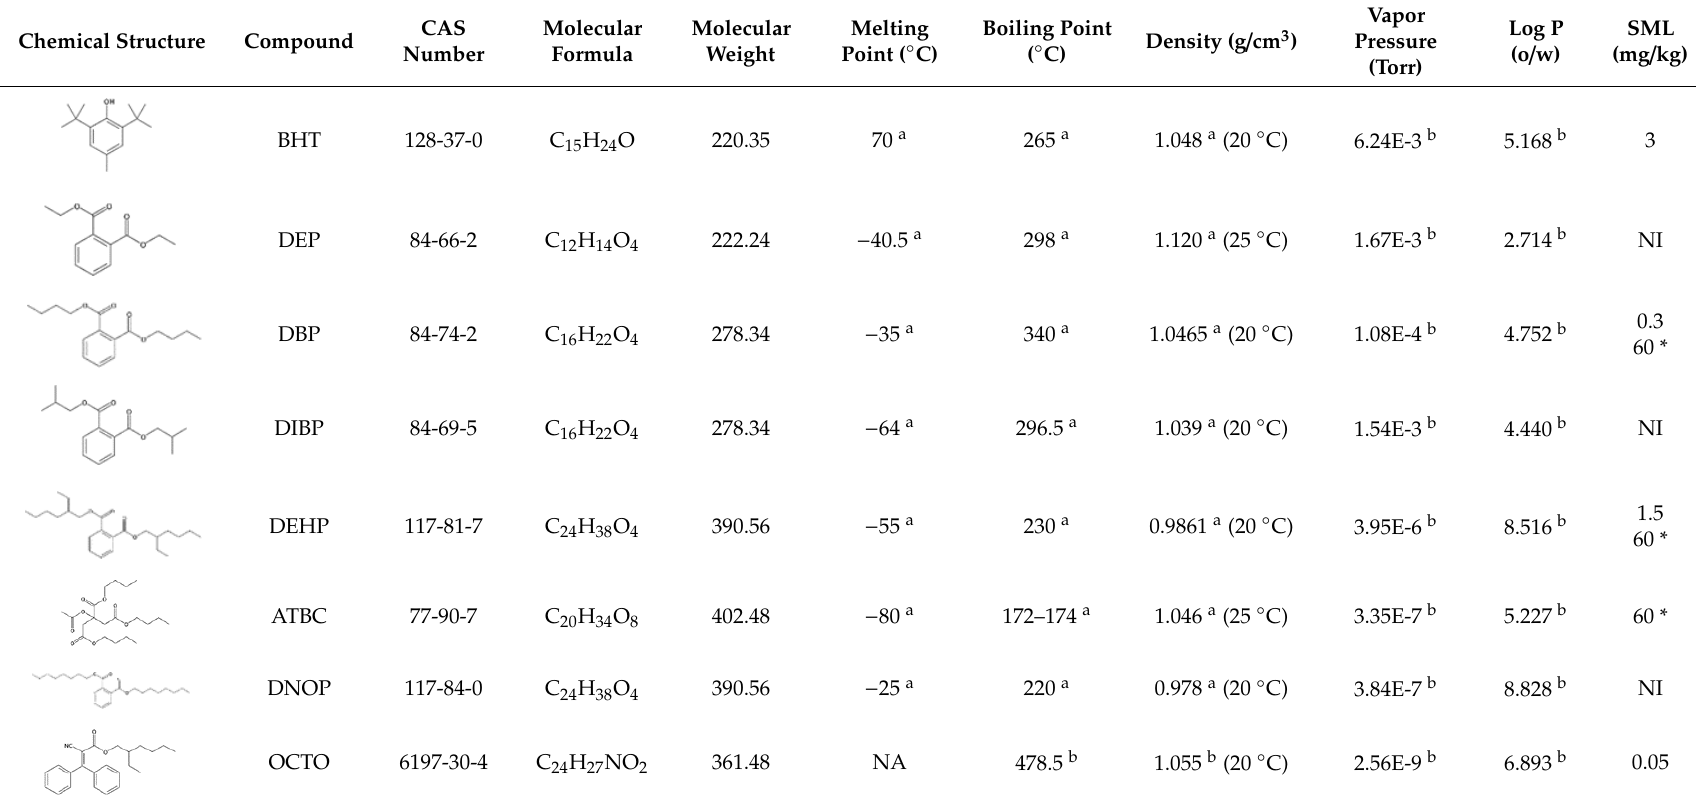
Table 1. Chemical structures and physicochemical characteristics of the target